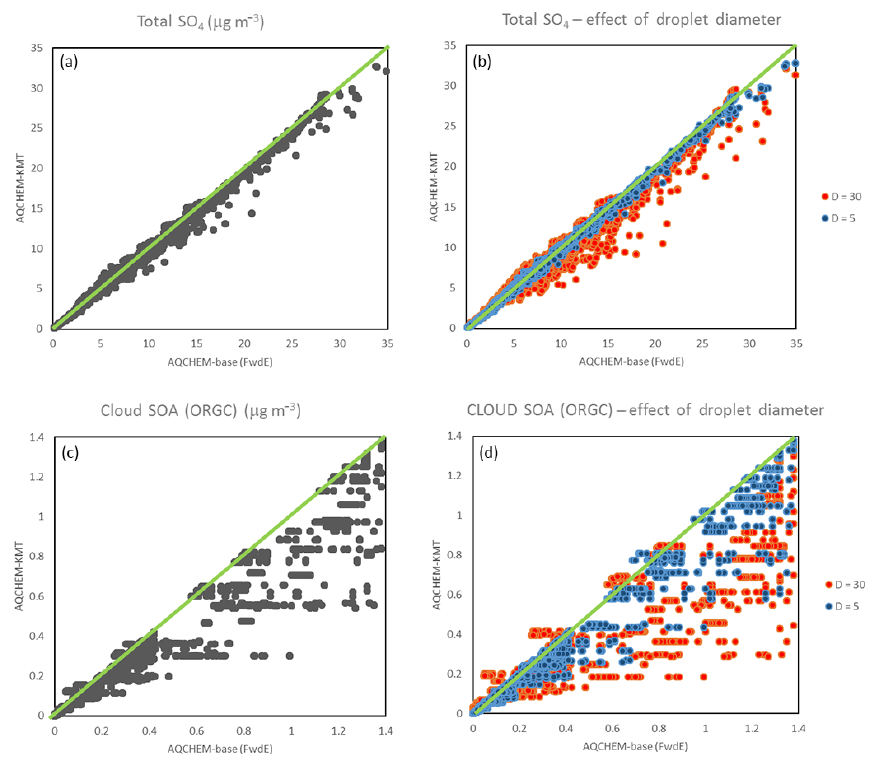
Figure 2. AQCHEM − KMT vs. standard AQCHEM predictions for (a) total SO 2 − of carbonyls (ORGC) at default droplet diameter of 16µm as well as at 5 and 30µm for (b) total SO 2 −